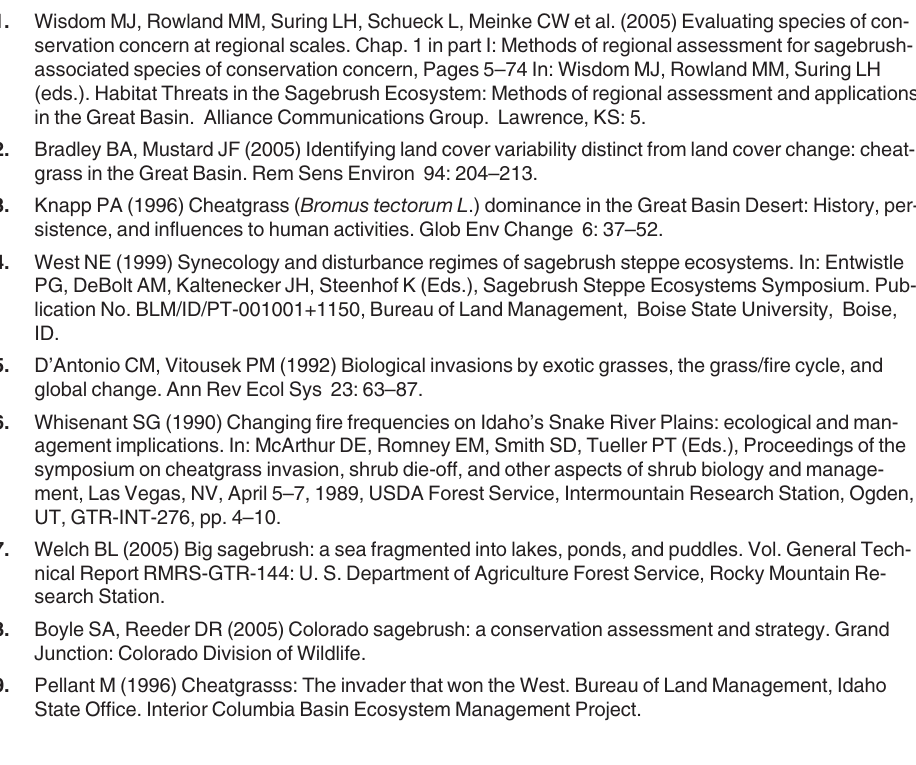
S3 Table. Genus-level composition (%) of sequences classifying within the Pleosporales for composite libraries from each of the four soil intervals examined. Composite libraries for each of the four soil intervals include the libraries generated from the six field replicates. S4 Table. Genus-level composition (%) of sequences classifying within the Hypocreales for composite libraries from each of the four soil intervals examined. Composite libraries for each of the four soil intervals include the libraries generated from the six field replicates. S5 Table. Genus-level composition (%) of sequences classifying within the Helotiales for composite libraries from each of the four soil intervals examined. Composite libraries for each of the four soil intervals include the libraries generated from the six field